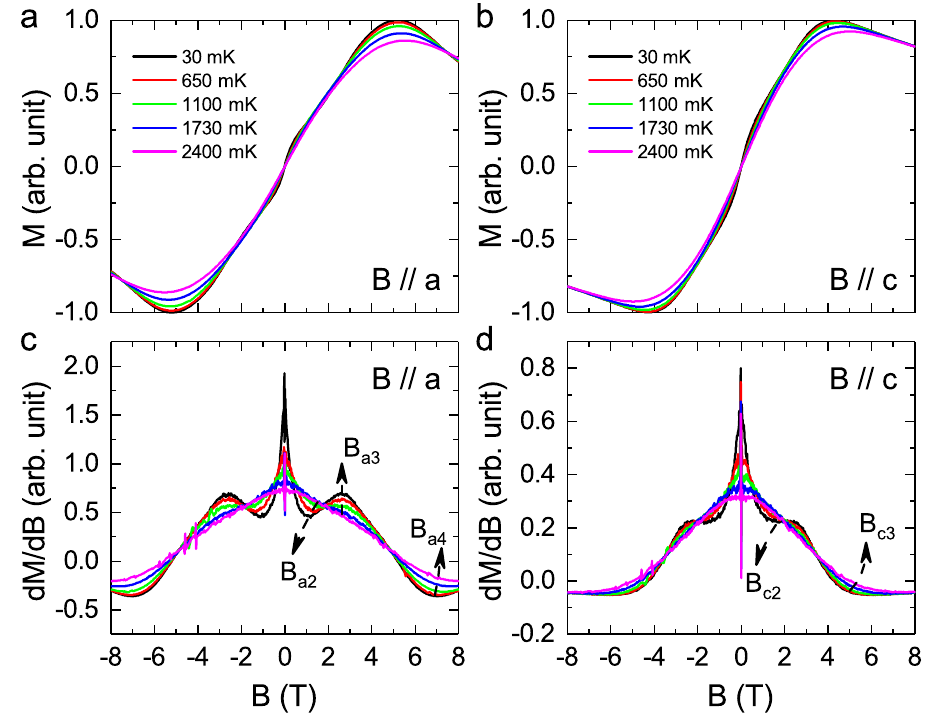
Fig. 4 Ultralow-temperature magnetization of YbMgGaO4. a , b The calculated magnetization ( M ) from the measured magnetic torque as torque/ B with fi eld-applied along either the a- axis or the c- axis (see Supplementary Fig. S1). c , d The derivative (d M /d B ) for B // a - or c- axis. At 30 mK, the derivative shows two anomalies at B a2 and B a3 for B // a , which are related to 1/3 M s and from the derivative for B // c , which is related to 1/2 M s